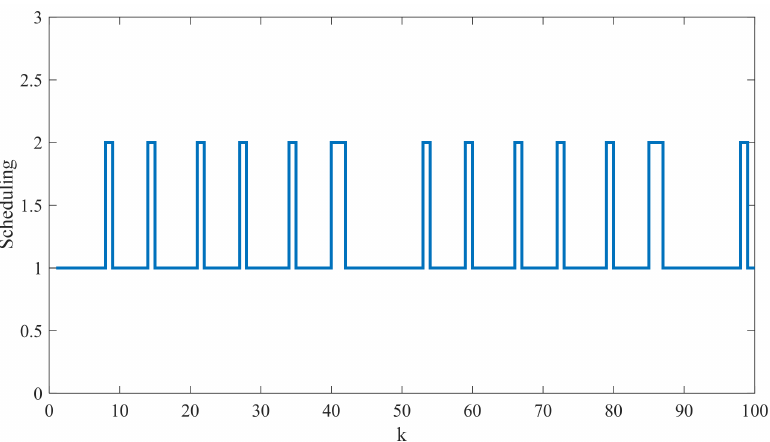
Figure 6. Scheduling of the co-design of the control and GMRS for the NCS without zero-order